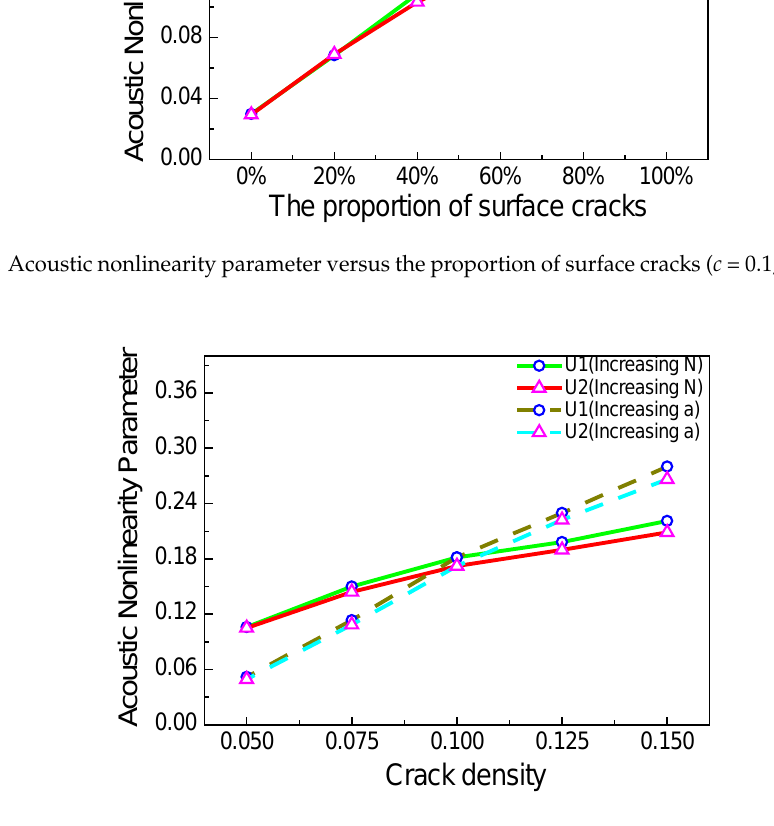
Figure 9. Acoustic nonlinearity parameter versus the crack density ( f = 1000 kHz, µ = 0.1, w % =